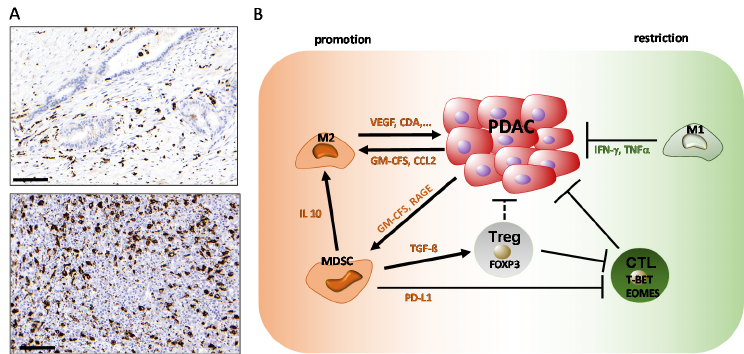
Figure 1. Tumor-associated macrophages (TAMs) and myeloid-derived suppressor cells (MDSCs) in pancreaticductaladenocarcinoma(PDAC).( A )Immunohistochemicalstainingofpan-monocyticmarker CD68 (macrosialin; dark brown signals) in examples of well-di ff erentiated, stroma-rich (upper panel) and poorly di ff erentiated, stroma-poor (lower panel) pancreatic ductal adenocarcinoma. Scale bar: 100 µ m. ( B ) Scheme of TAM functions in